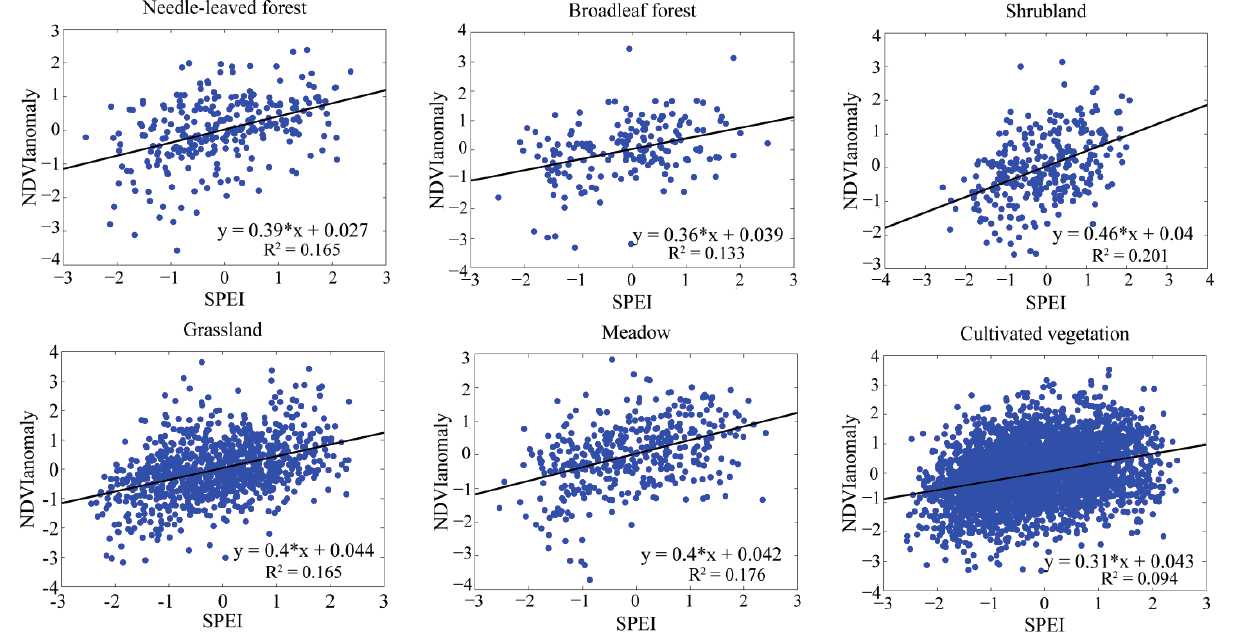
Figure 6. The responses of vegetation to the drought based on the